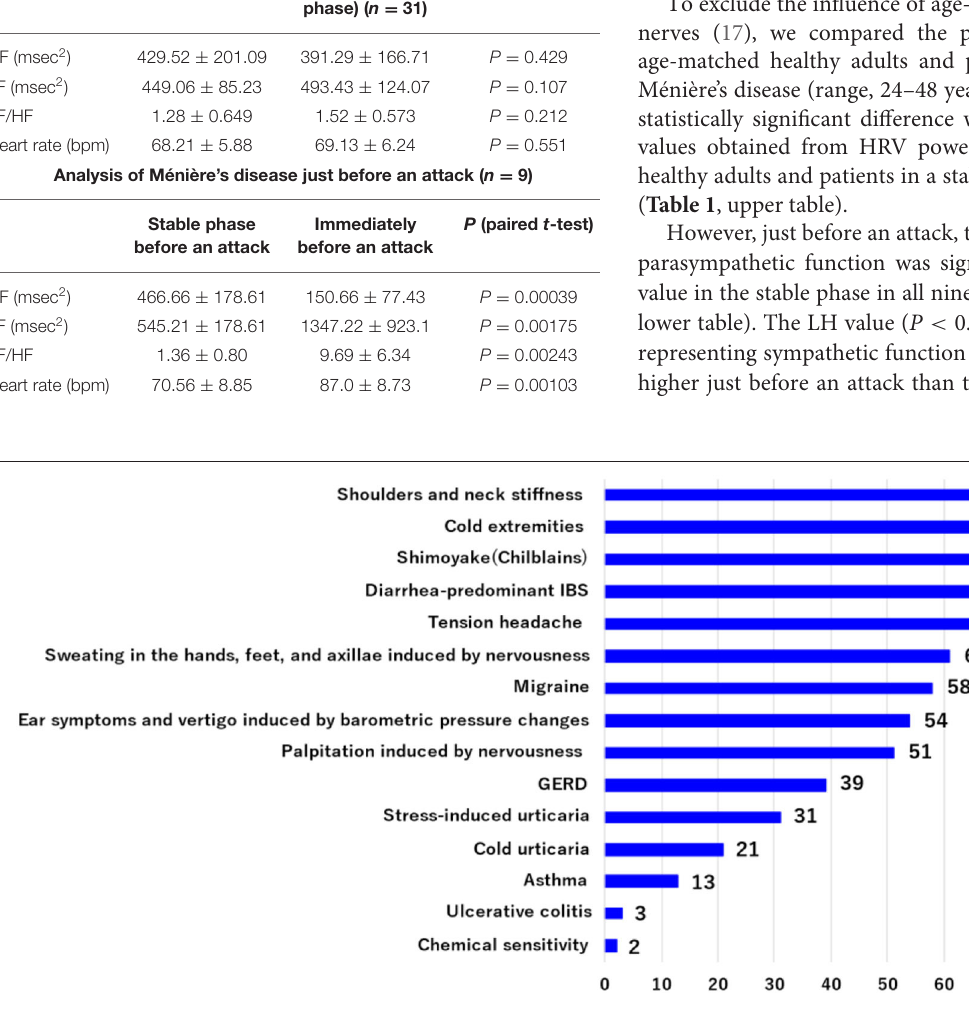
FIGURE 2 | The incidence of co-occurring symptoms was evaluated in 211 patients with Ménière’s disease who had had three or more vertigo attacks. These symptoms include multiple occurrences. Many of these symptoms are associated with stress and are accompanied by the excitation of sympathetic nerves.